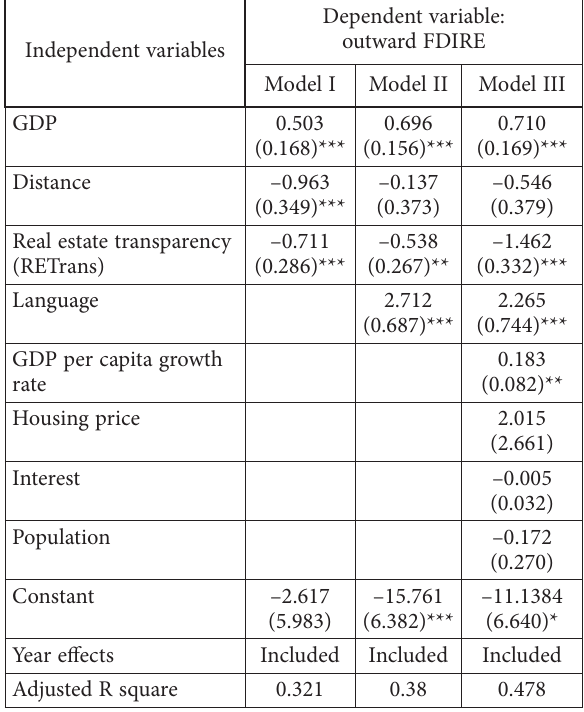
Table 3. Determinants of Chinese outward